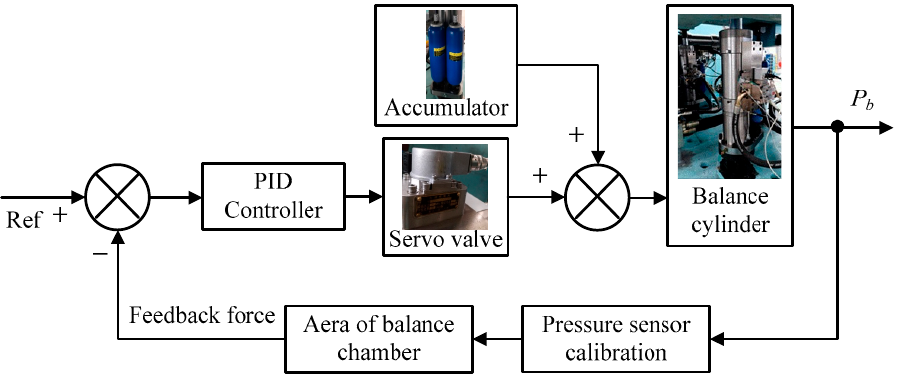
Figure 6. The developed gravity balance system.